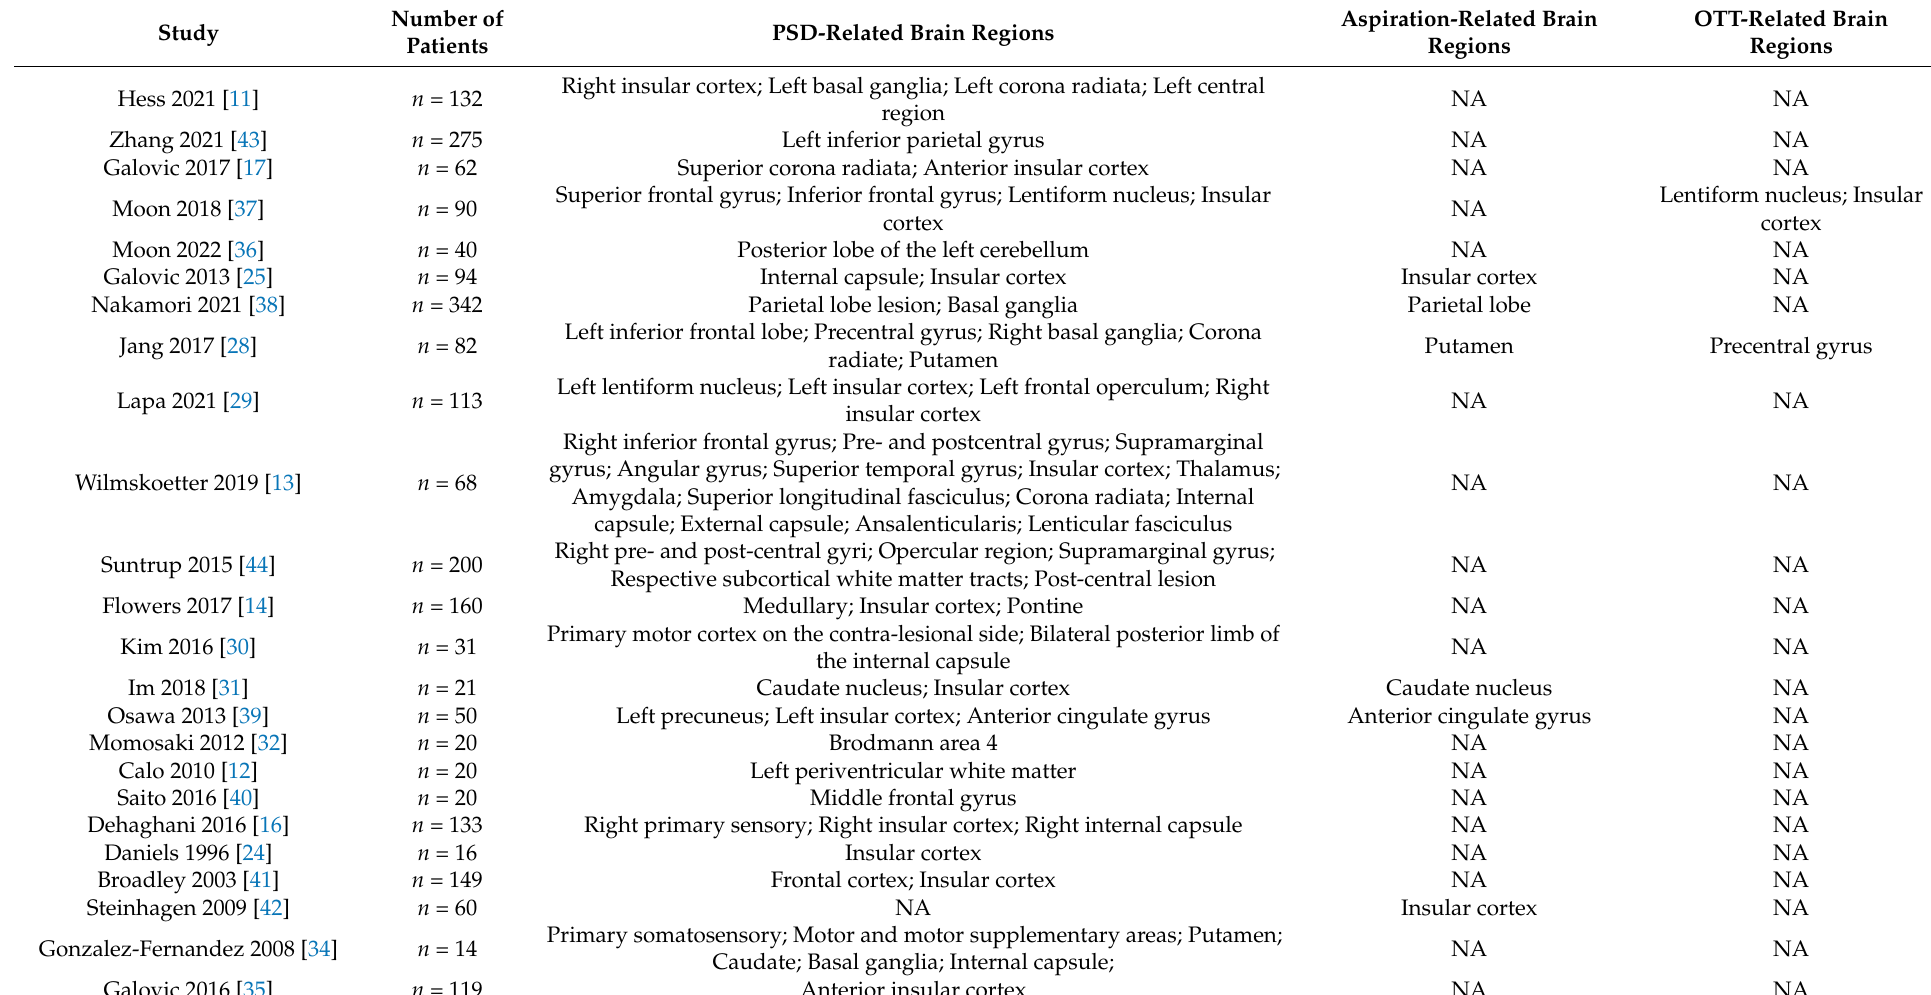
Table 3. The PSD-related brain regions, aspiration-related brain regions, and OTT-related brain regions. Number of Study